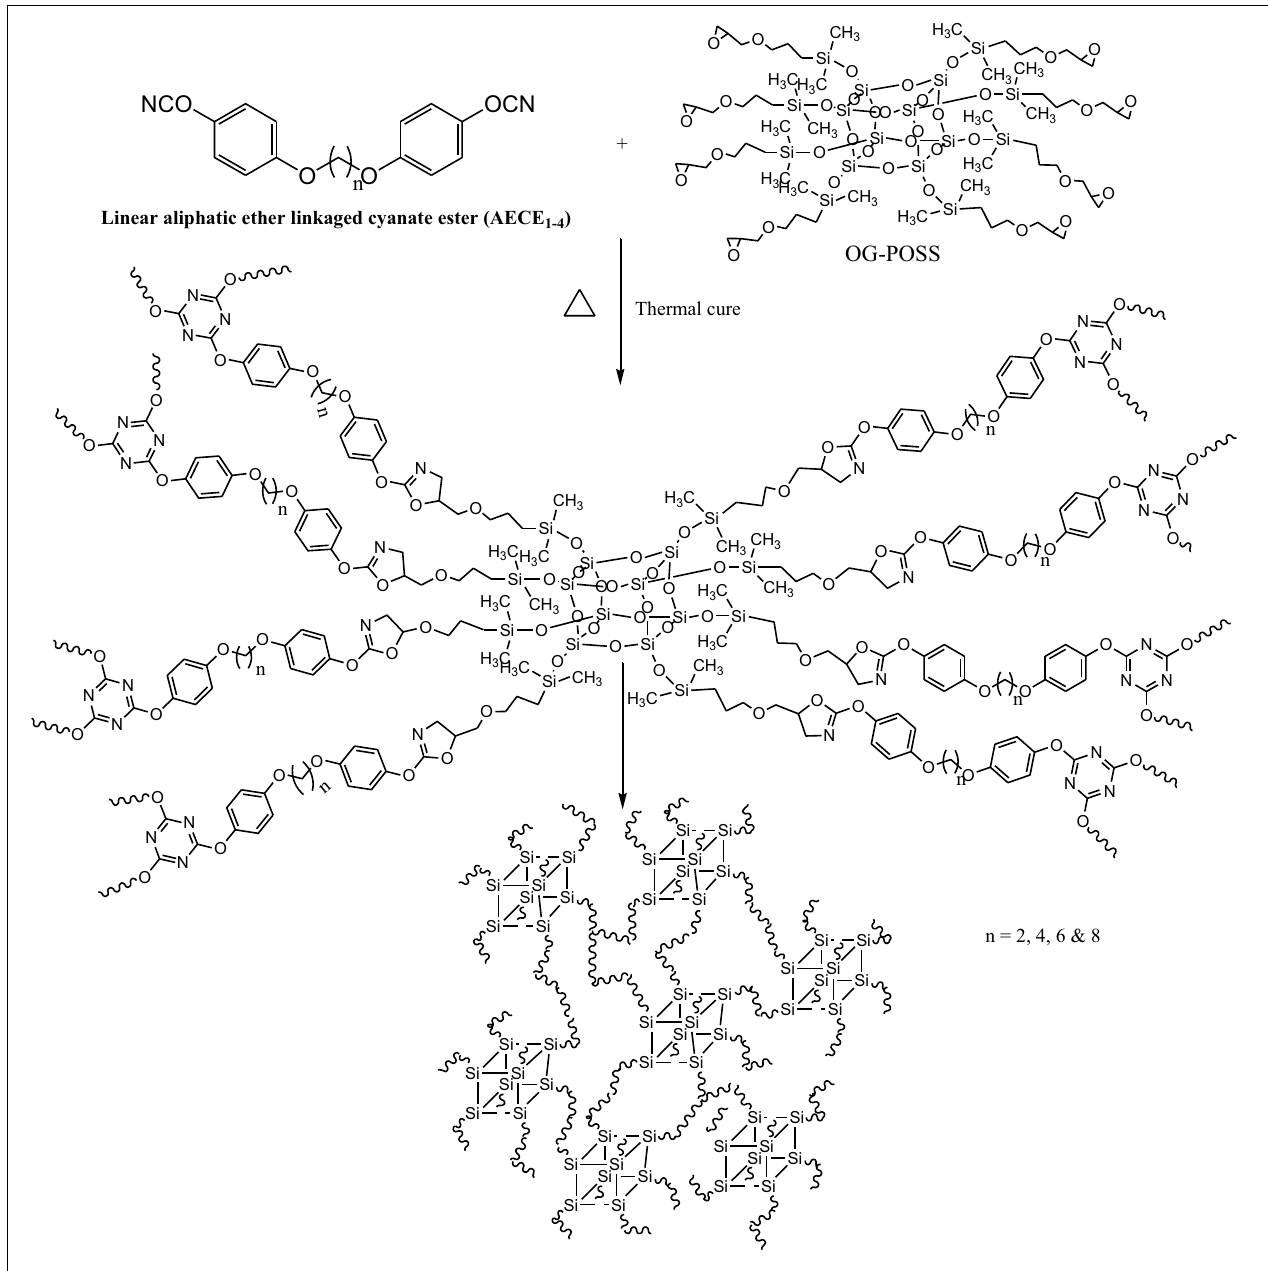
Scheme 2 | Schematic representation of POSS-AECE